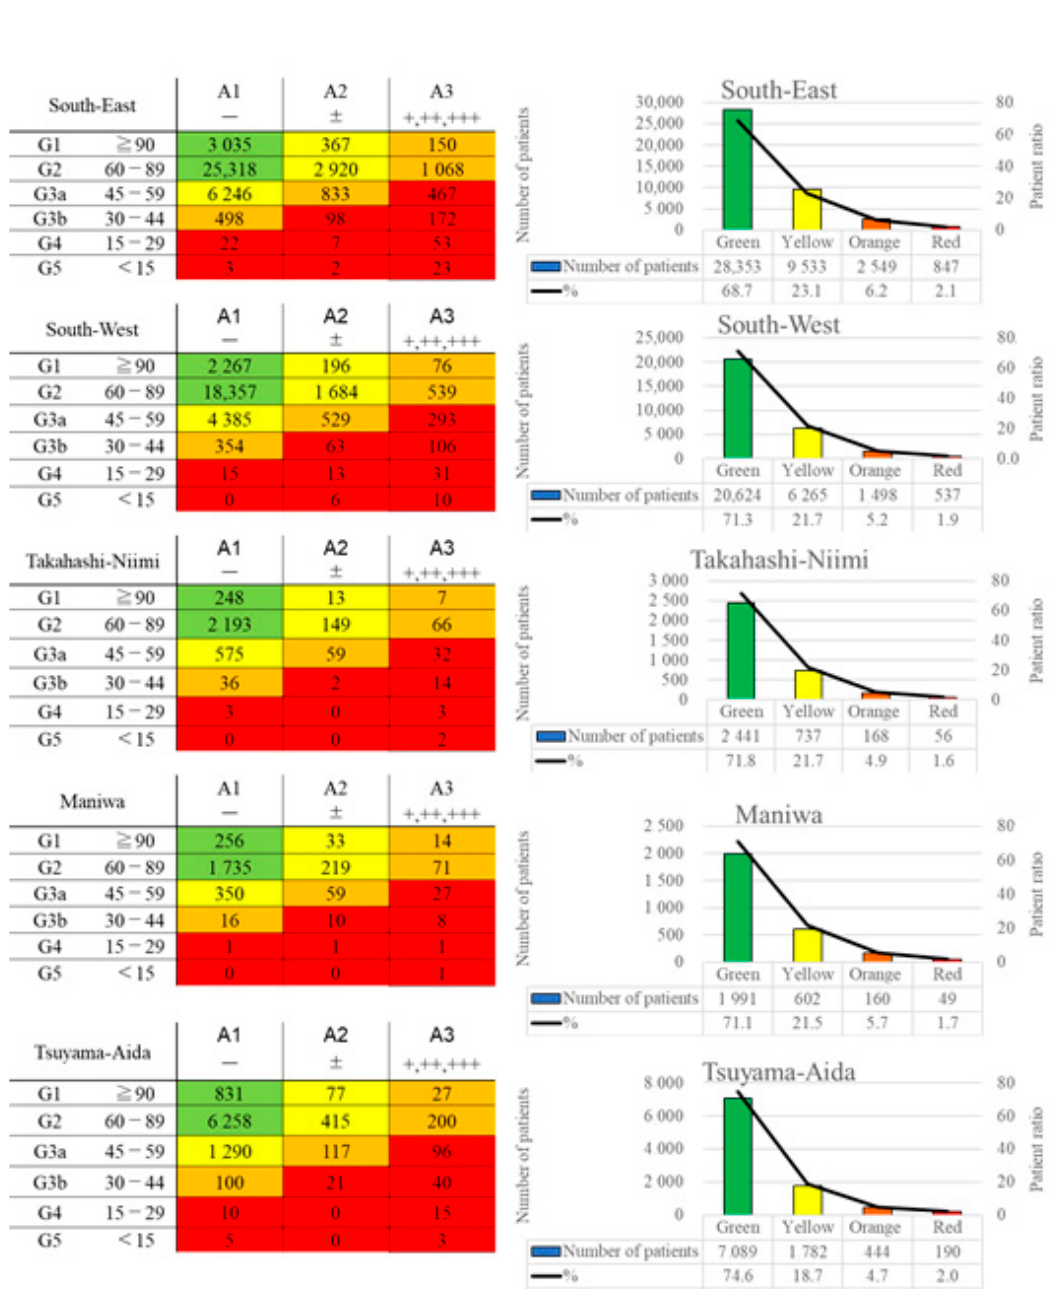
Figure 1. CKD heatmaps of each region. The left column shows the actual number of people in each category by the renal function and proteinuria, and the right column shows the number and proportion of people classified by risk of ESRD. ESRD: end-stage renal disease.